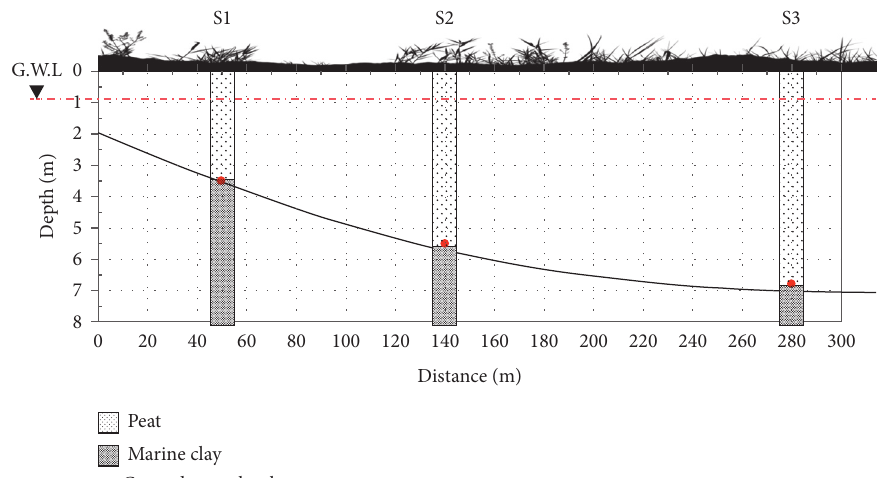
Figure 5: Soil stratigraphy delineated at the study